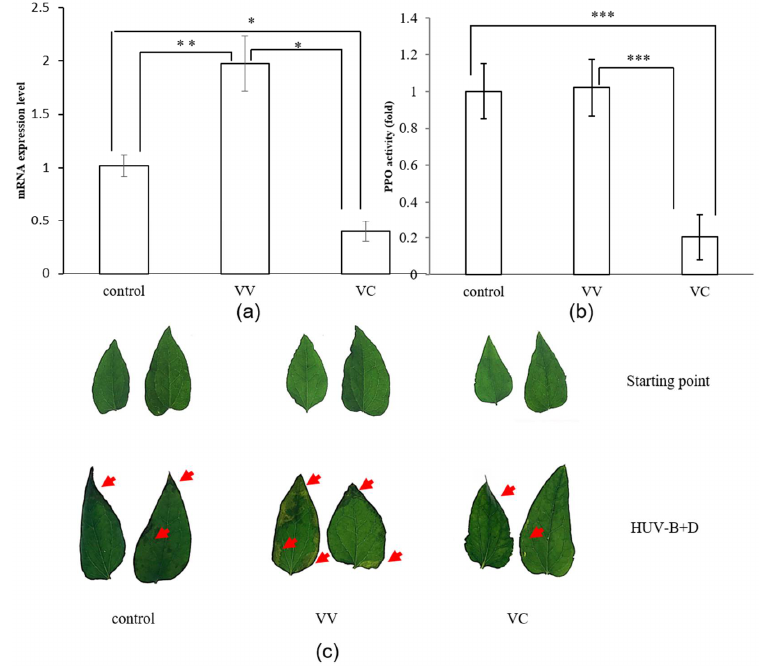
Figure 1. ( a ) Expression levels of CtPPO gene mRNA in leaves of C. terniflora in control, VIGS-vector, and VIGS-CtPPO plants. Data are shown as mean ± SD of the independent biological replicates. Asterisks indicate significant changes as measured by Student’s t -test (* p < 0.05, ** p < 0.01, and *** p < 0.001); ( b ) PPO activity was assayed in C. terniflora leaves of control, VIGS- vector and VIGS-CtPPO plants. Data are shown as mean ± SD of independent biological replicates. Asterisks indicate significant changes as measured by Student’s t -test (* p < 0.05, ** p < 0.01, and *** p < 0.001); ( c ) Morphology of control, VIGS-vector, and VIGS-CtPPO C. terniflora plants before and after HUV-B+D treatment. Photograph showing C. terniflora growth under different treatments. The damaged areas were marked with red